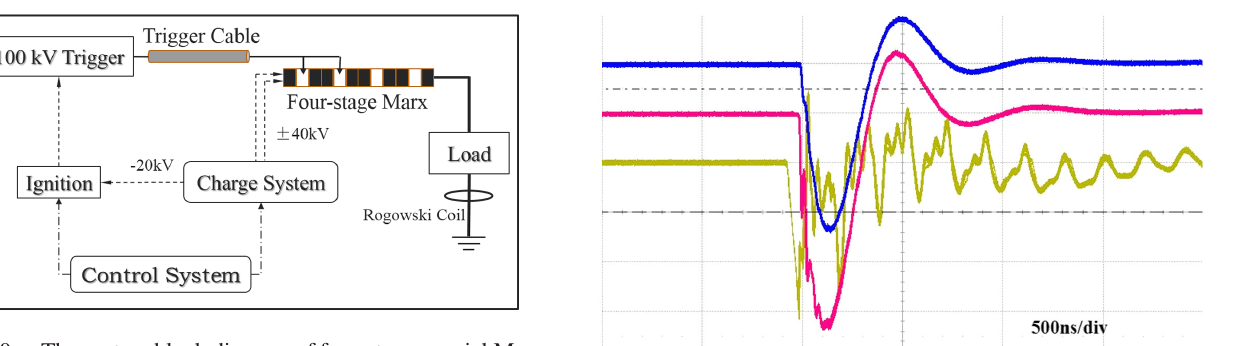
FIG. 10. The system block diagram of four-stage coaxial Marx.